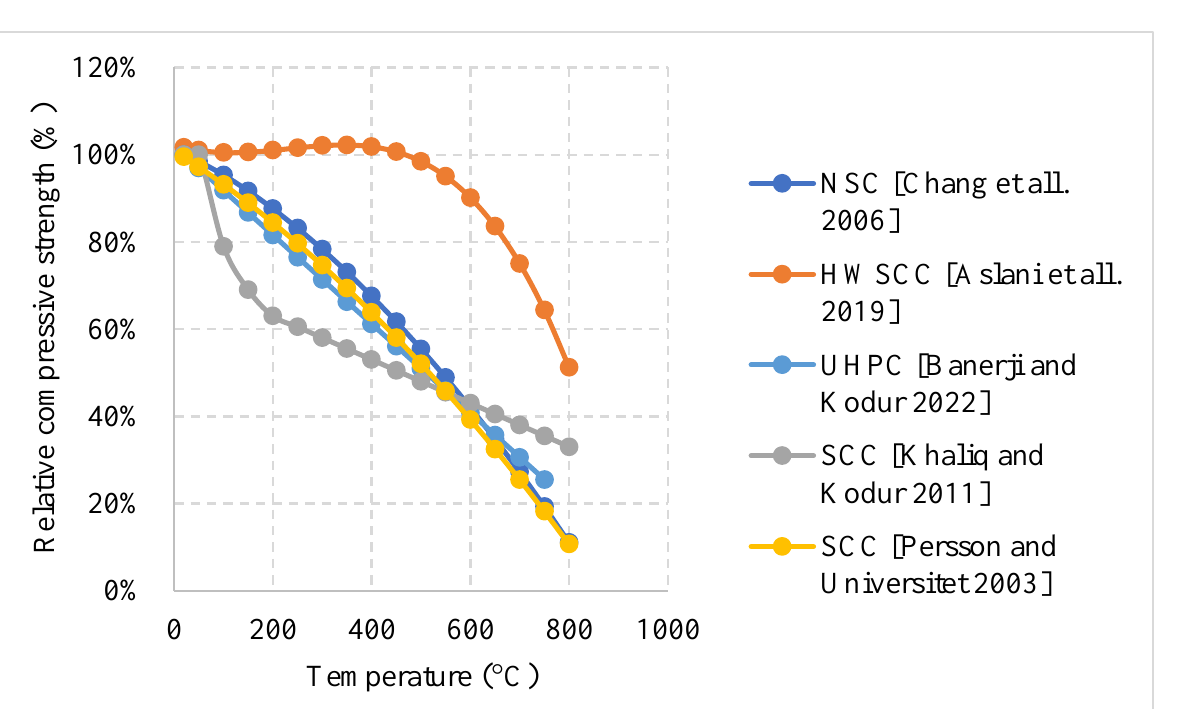
Figure 48. Relative tensile strength models for different types of concrete [5,48,84,97,108,135].